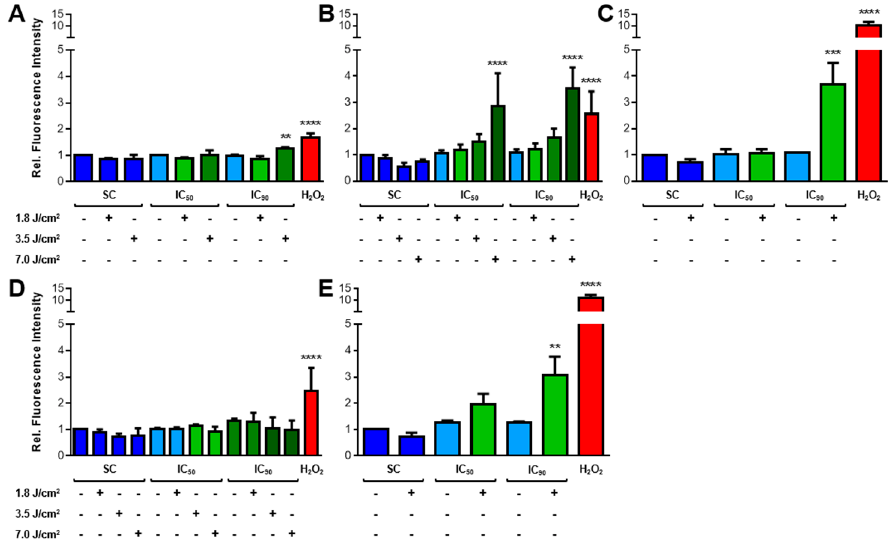
Figure 3. Reactive oxygen species (ROS) formation after mTHPC-PDT in A-427 ( A ), BHY ( B ), KYSE-70 ( C ), RT-4 (D), and SISO ( E ) cells. Cells were treated with solvent (SC) or equitoxic concentrations (IC 50 or IC 90 in Table 1) of mTHPC between 0.02–0.3 µM, illuminated with 1.8 J/cm 2 , 3.5 J/cm 2 , and 7.0 J/cm 2 or left in the dark, stained with H 2 DCF-DA and DCF fluorescence intensity was measured directly after illumination. Flow cytometric analysis of the single cell population was carried out using the FITC channel ( λ Ex/Em = 488/525–550 nm). Fluorescence intensity was plotted with reference to non-illuminated, solvent-treated cells (fluorescence intensity was set to 1.0). Cells treated with 1.0–2.0 mM H 2 O 2 for 10 min were used as positive control. Data presented as means ± SD from at least three independent experiments. (** p < 0.01; *** p < 0.001; **** p <